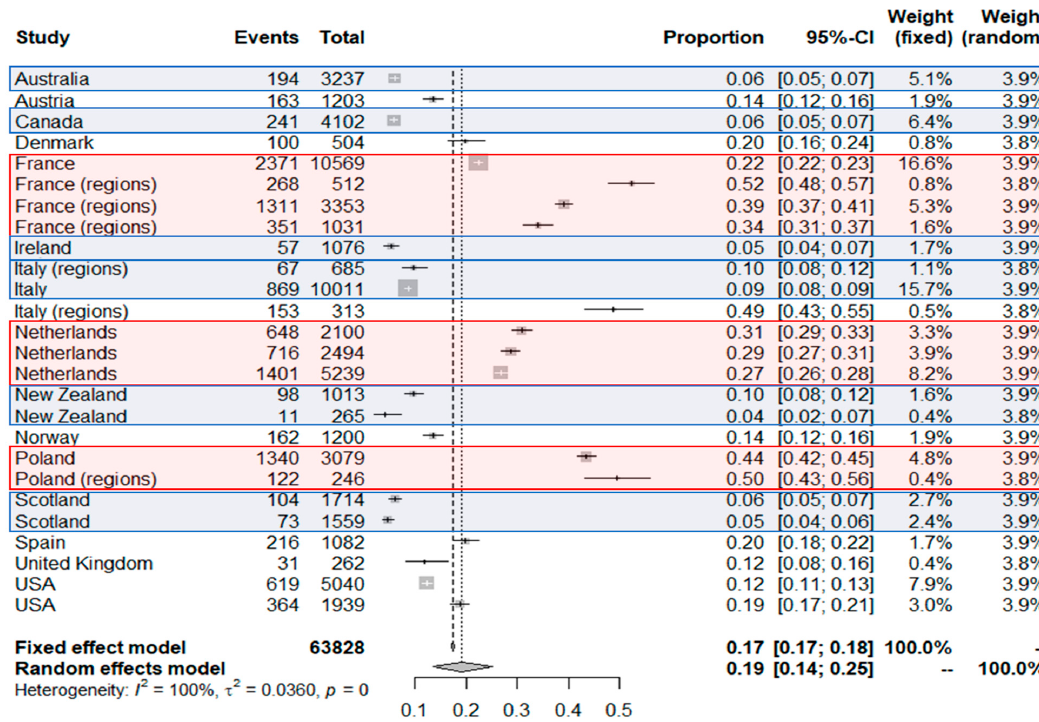
Figure 2. Results of the meta-analysis: Seroprevalence among blood donors in industrialized countries using Wantai HEV-IgG ELISA assay. Red areas correspond to countries with seroprevalence higher than the overall seroprevalence and blue areas to those with lower value. Black crosses correspond to the seroprevalence value of each study. The size of the grey square around the cross depend on the number of samples of each study included (weight). Black bars around the point correspond to the confidential interval. The additional data for each study included in the meta-analysis are presented in Table 2.